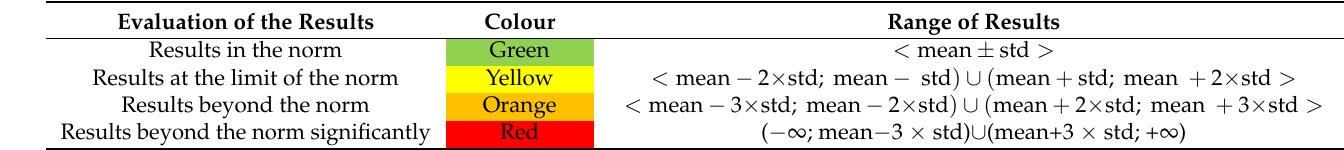
Table 1. Classification ranges of parameter